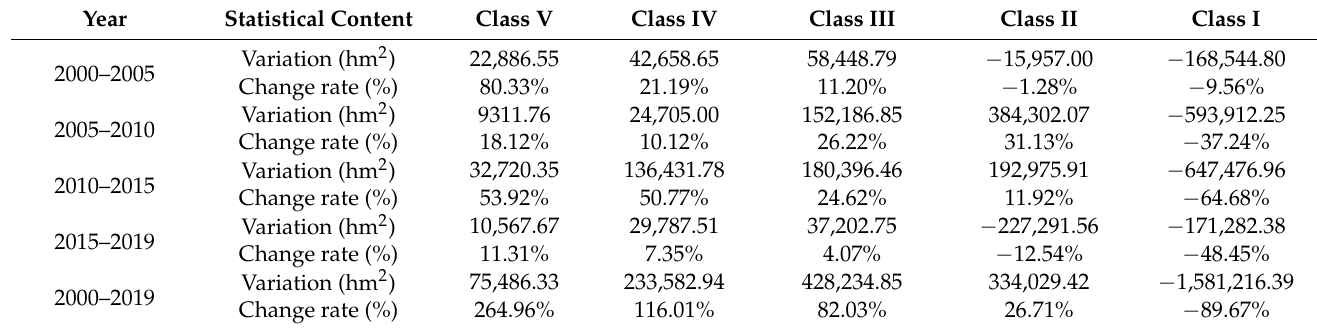
Table 4. Changes in cultivated land area of different levels in the two lake